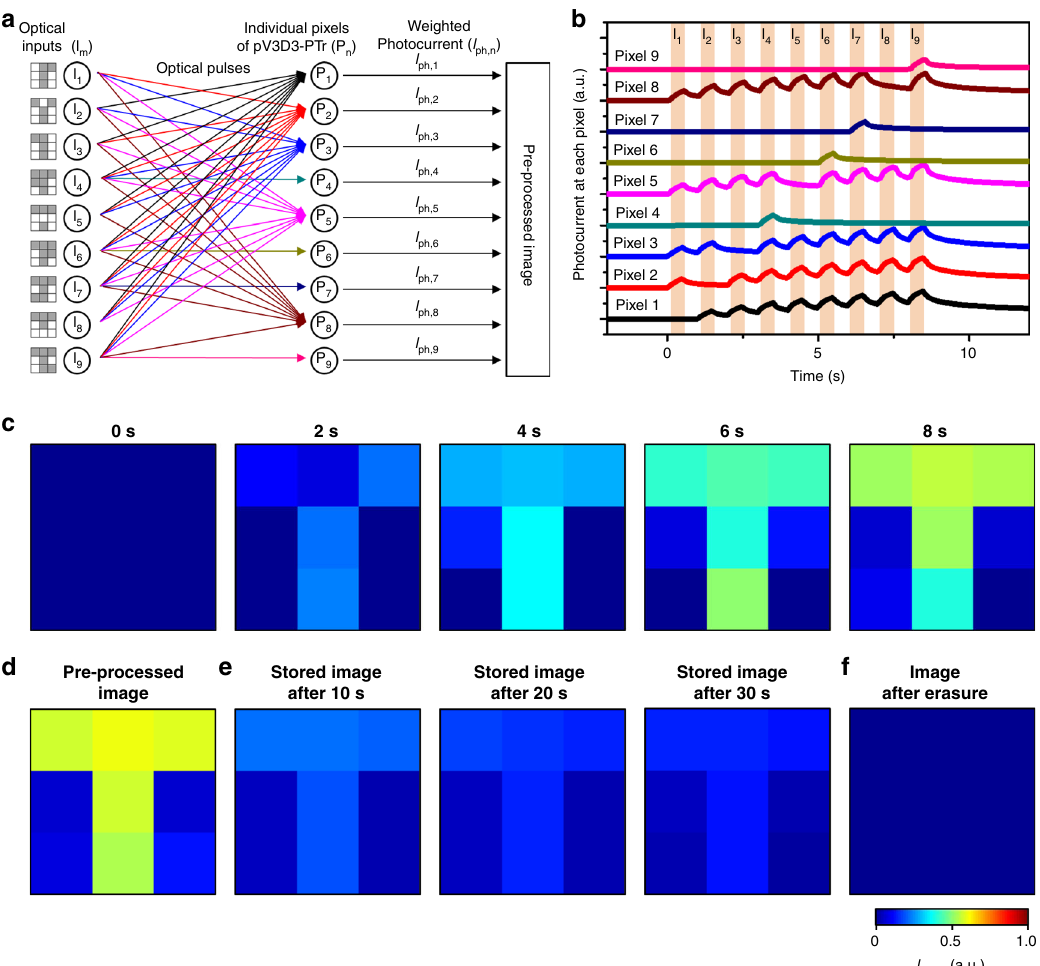
Fig. 3 Operation principle of the neuromorphic imaging device. a Schematic diagram showing the image acquisition and neuromorphic data pre- processing by using a 3 × 3 pV3D3-PTr array. b Normalized photocurrent measured at each pixel of the 3 × 3 pV3D3-PTr array. c Acquired image at each time point. d Pre-processed image obtained through image acquisition and neuromorphic data pre-processing. e Pre-processed image stored in the array while photocurrents of individual pixels slowly decay. f Erasure of the memorized image by applying a positive gate bias (i.e., V g = 1